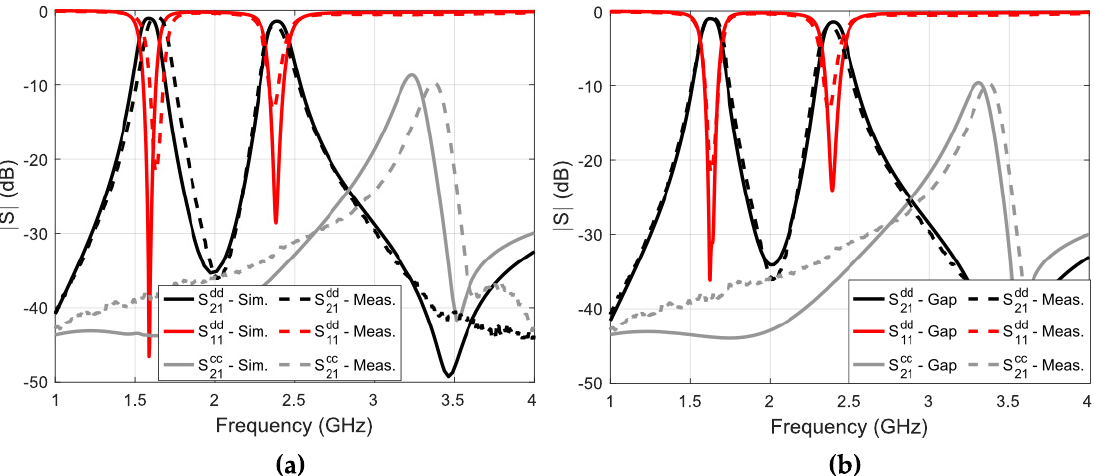
Figure 9. Simulated and measured response of the proposed dual-band bandpass filter: ( a ) without gap; ( b ) with an air gap of 0.025 mm.